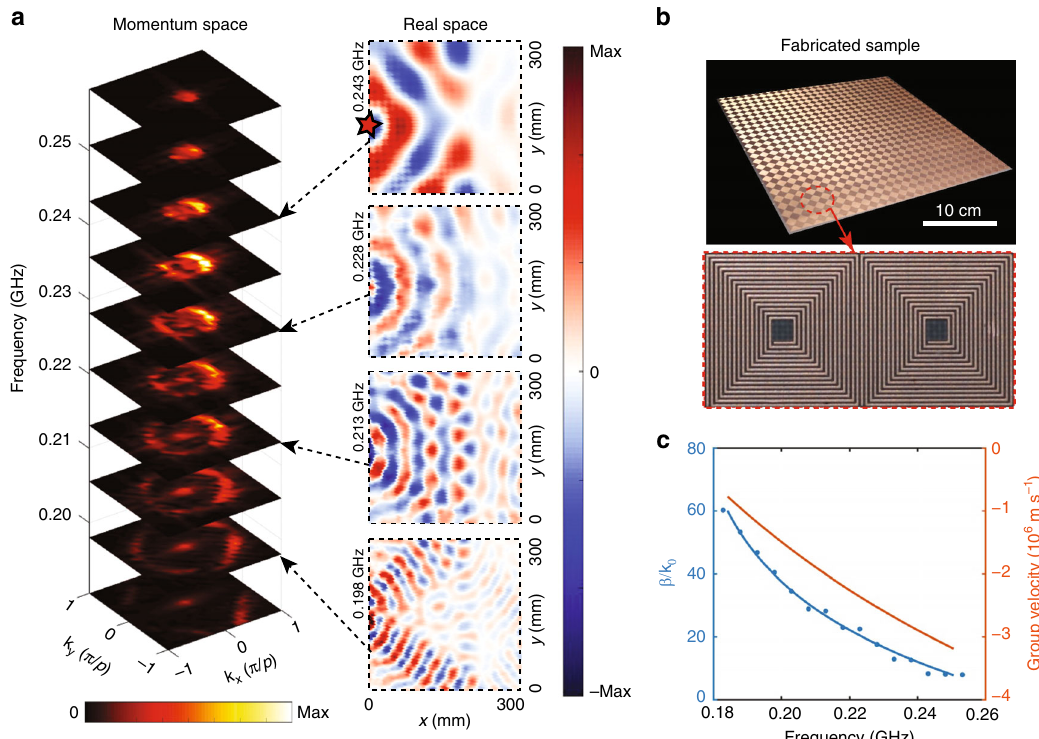
Fig. 4 Measured momentum space, fi eld distributions in real space, and retrieved dispersion and group velocity of the designer polaritons on the type-I hyperbolic metasurface. a Measured momentum space of the designer polaritons in the FBZ, and measured Hz fi eld distributions on the plane 5 mm over the metasurface (22 by 22 unit cells) at 0.198, 0.213, 0.228, and 0.243 GHz, respectively. The red star in the right inset represents the source location. b Photograph of the metasurface sample. Inset: two unit cells of the metasurface. c Retrieved squeezing factor and group velocity of the designer polaritons from the experimental results. Here, the blue dots are the experimental data; the blue curve represents exponential fi ts to the experimental data; the orange curve is the group velocity obtained from the blue curve